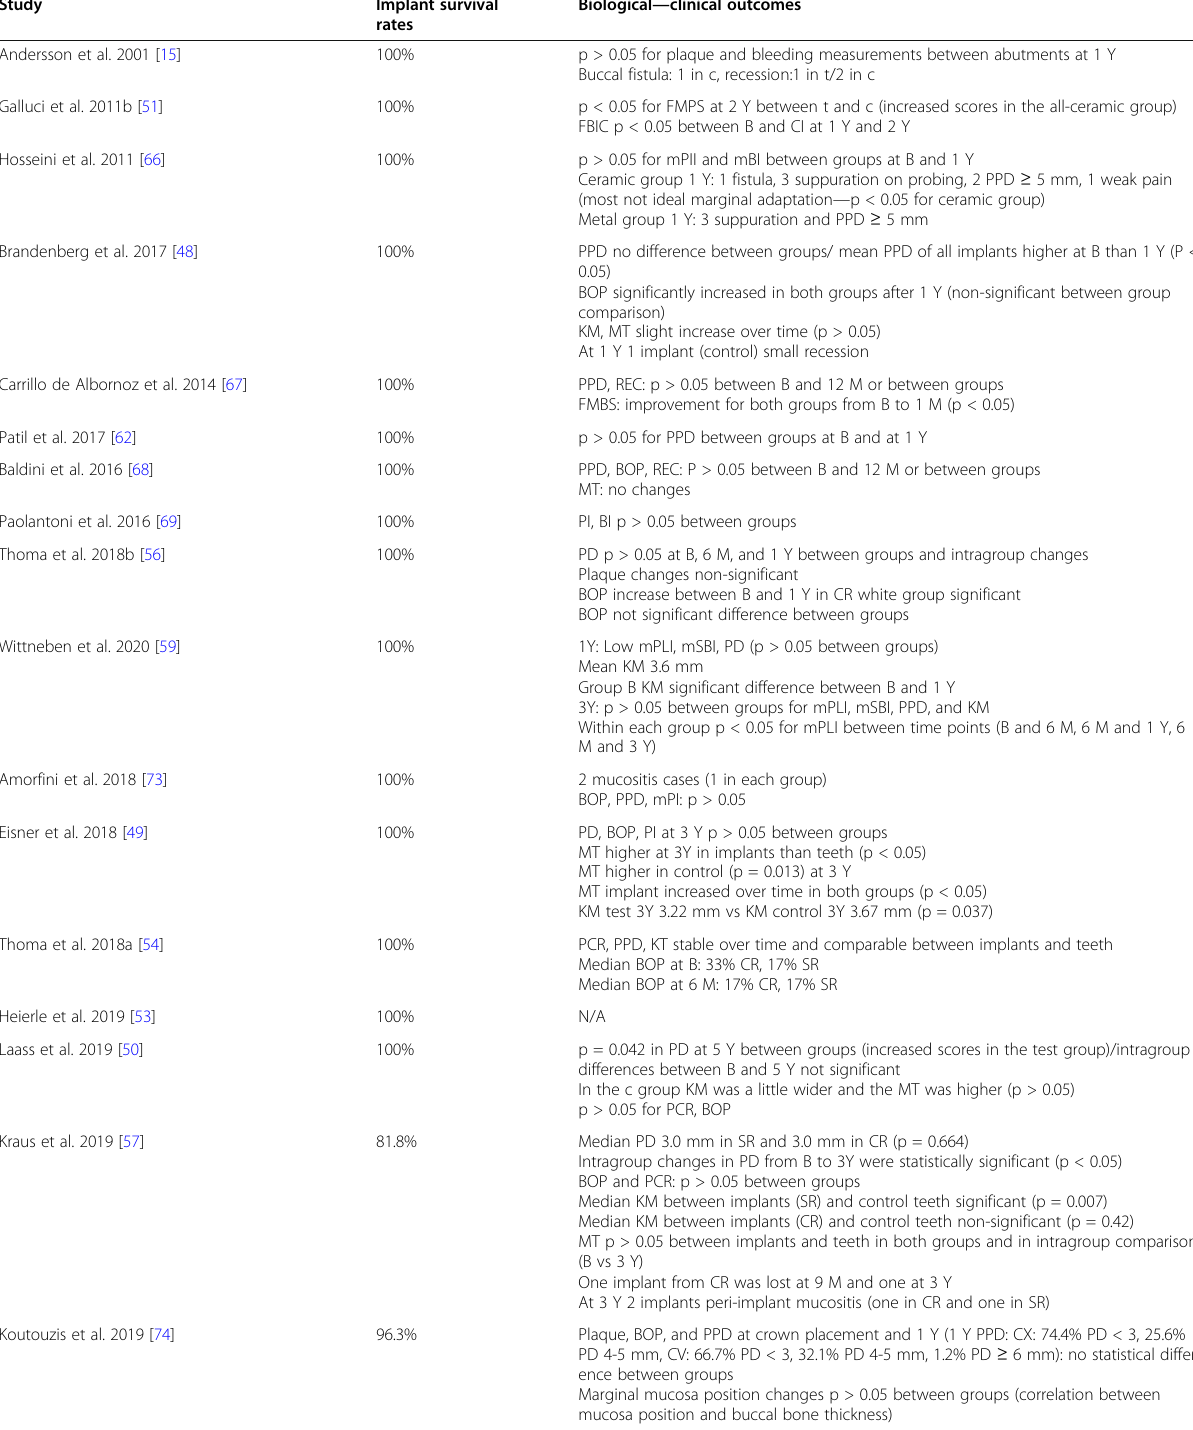
Table 7 Biological